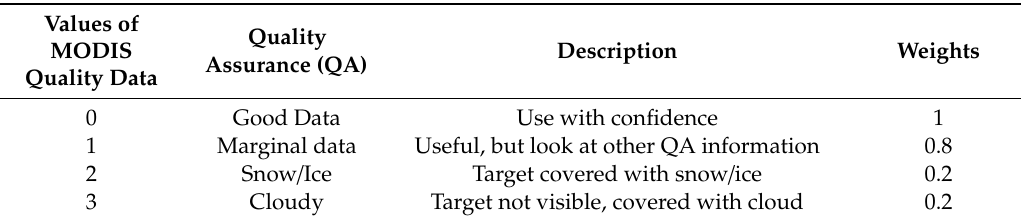
Table 1. Weights given when fitting vegetation curve.